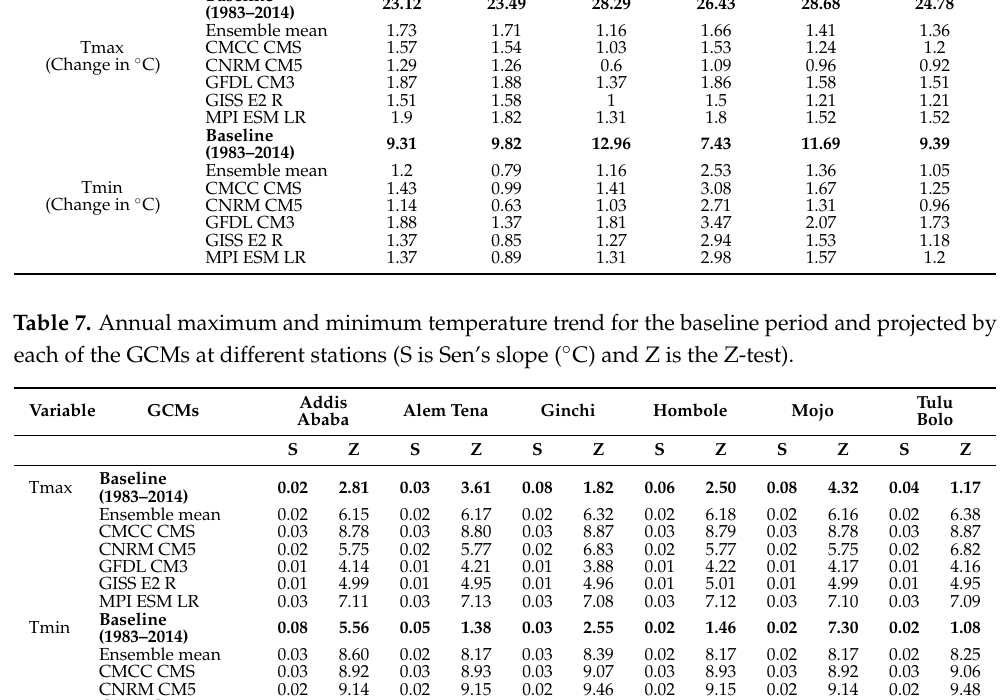
Table 6. Mean annual Tmax and Tmin for the baseline and change ( ◦ C) for different GCMs and the ensemble mean of the five GCMs. Ginchi Addis Ababa Alem Tena Hombole